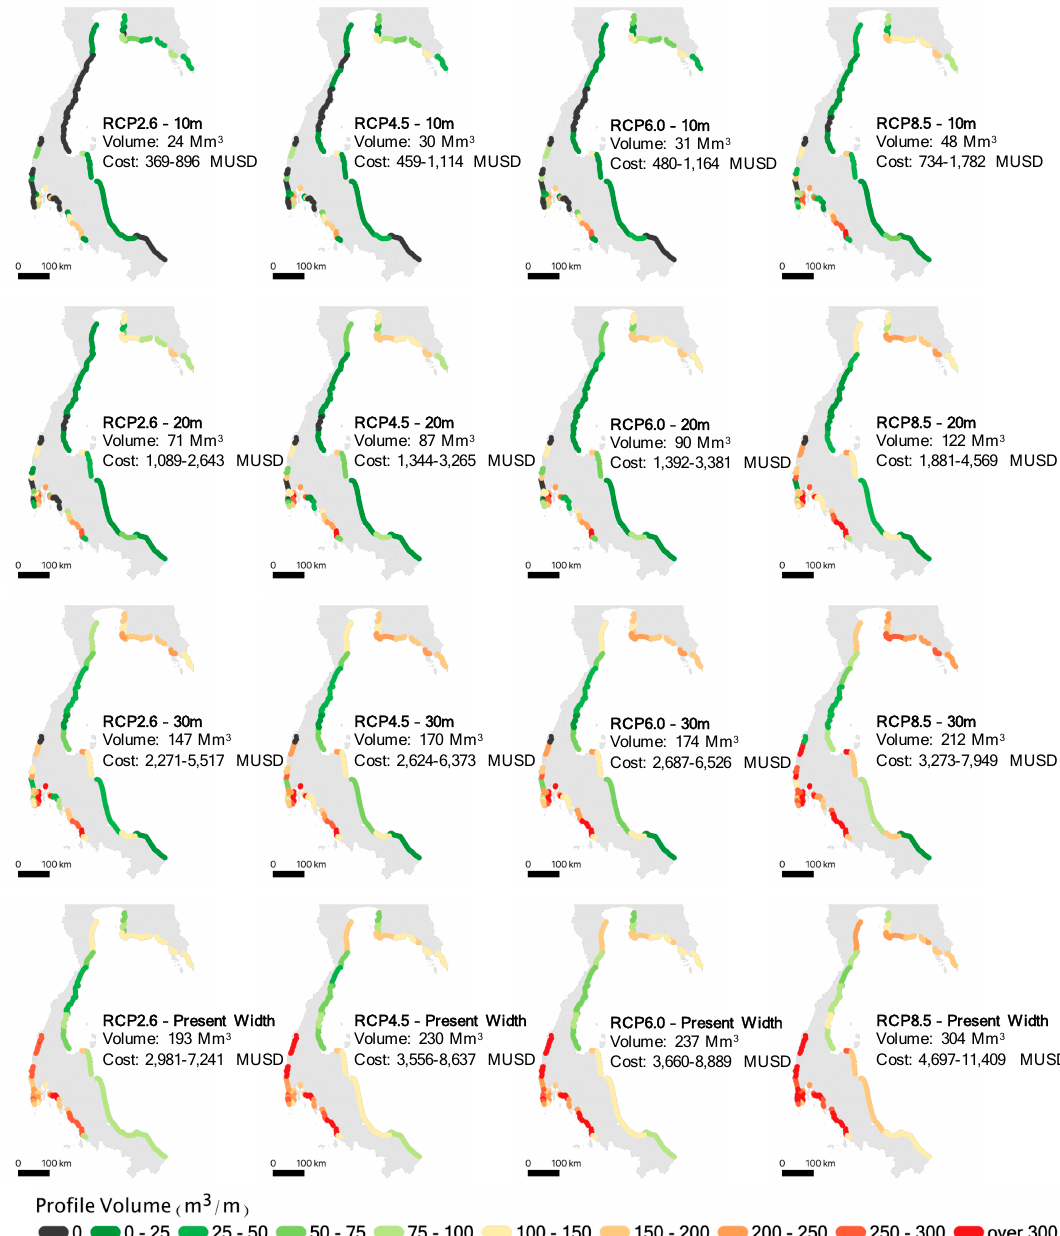
Figure 7. The profile volume in m 3 / m of sand for beach nourishment for each sandy beach zone and designed beach width, 10, 20, 30 m and present beach width (the top row to bottom row, respectively), for RCP2.6, RCP4.5, RCP6.0 and RCP8.5 (left column to right column, respectively). The total volume for the entire sandy beaches is presented with the maximum and minimum cost of sand in million USD (MUSD). The sand volume was calculated by applying the same size of the filling particle and the native